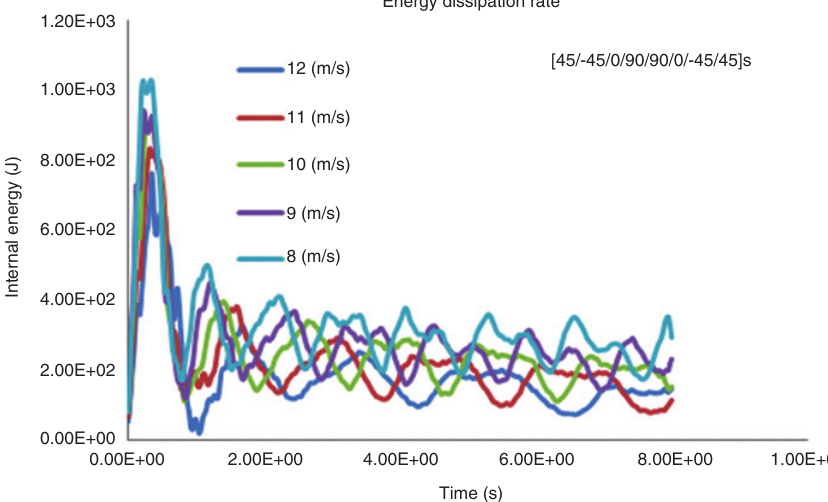
Figure 8 Energy dissipation rate of the stacking sequence of [45/-45/0/90/90/0/-45/45]s at various impacting speeds.